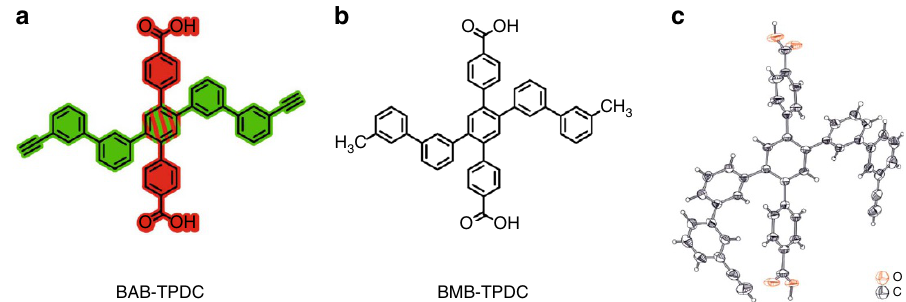
Figure 2 | Structure of organic linkers. ( a ) Chemical structure of quadritopic (4t) organic linker BAB-TPDC (bis(acetylene-biphenyl)-terphenyl di carboxylic acid). ( b ) Chemical structure of the ditopic linker BMB-TPDC (bis(methyl-biphenyl)-terphenyl di carboxylic acid). ( c ) Solid state structure of BAB-TPDC determined by X-ray crystallography (ellipsoids plotted at a 50%